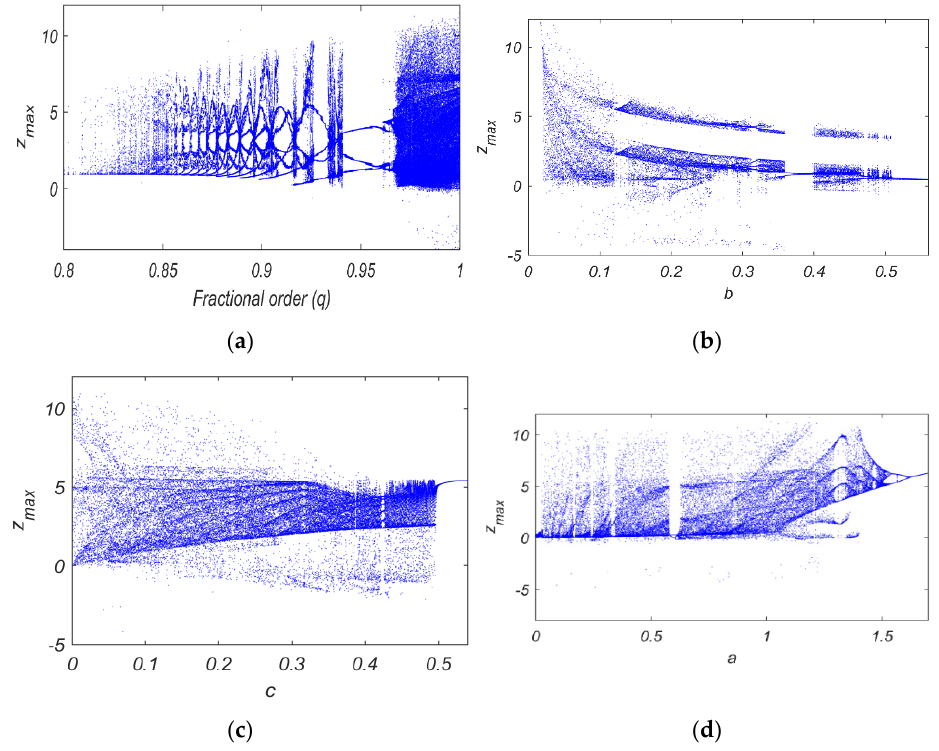
Figure 4. The bifurcation diagram of the new system: ( a ) Z max versus a for b = 0.4, c = 0.4, and q = 0.98; ( b ) Z max versus b for a = 1, c = 0.4, and q = 0.98; ( c ) Z max versus c for a = 1, b = 0.4, and q = 0.98; ( d ) Z max versus fractional-order derivative value ( q ) with a = 1, b = 0.4, and c = 0.4.